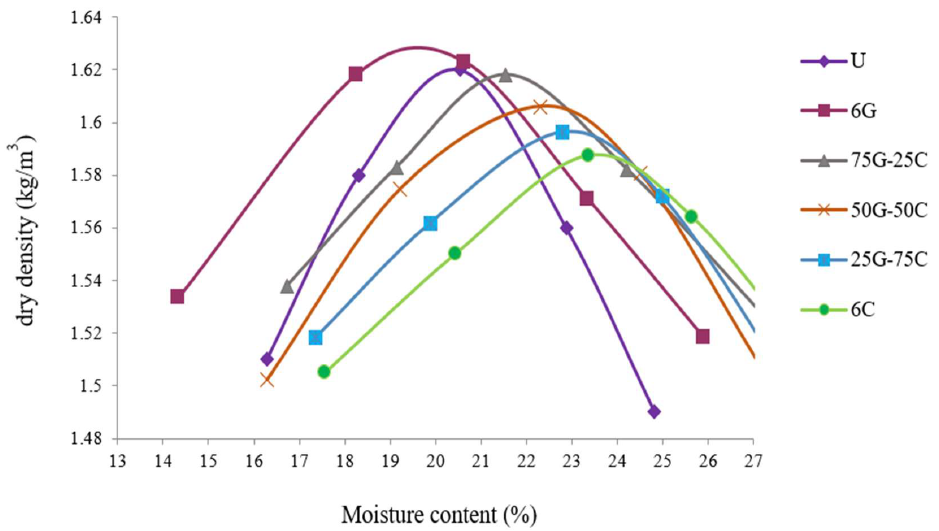
Figure 5. The compaction parameters of untreated and treated soil samples.